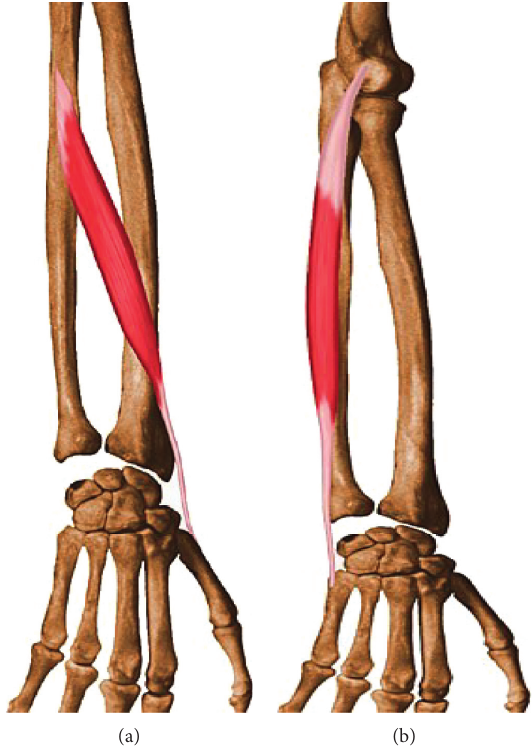
Figure 1: Forearm muscles considered in the experimental approach. Table 1: Generated Arabic letters and geometric forms. Name of the form Form Horizontal line (left right